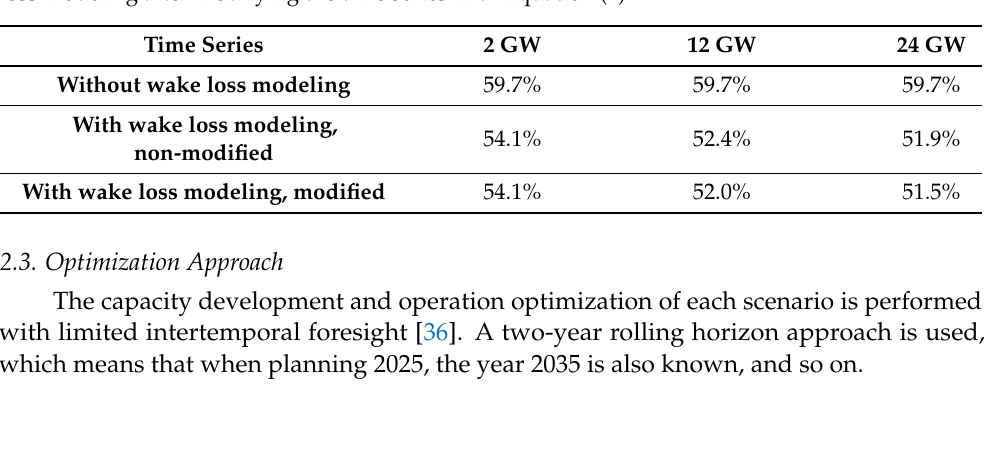
Table 2. Average annual capacity factor of a wind farm installation far offshore in German waters for different installation sizes. Resulting values when not including wake loss modeling, when including wake loss modeling before modifying the time series with Equation (2), and when including wake loss modeling after modifying the time series with Equation